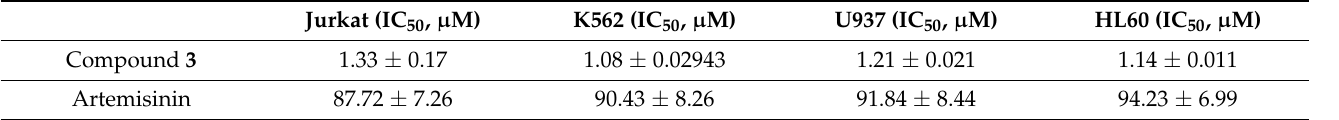
Table 1. In vitro cytotoxic activity of azaperoxide 3 on tumor cell cultures (Jurkat, K562, U937, HL60) ( µ M). Jurkat (IC 50 , µ M)